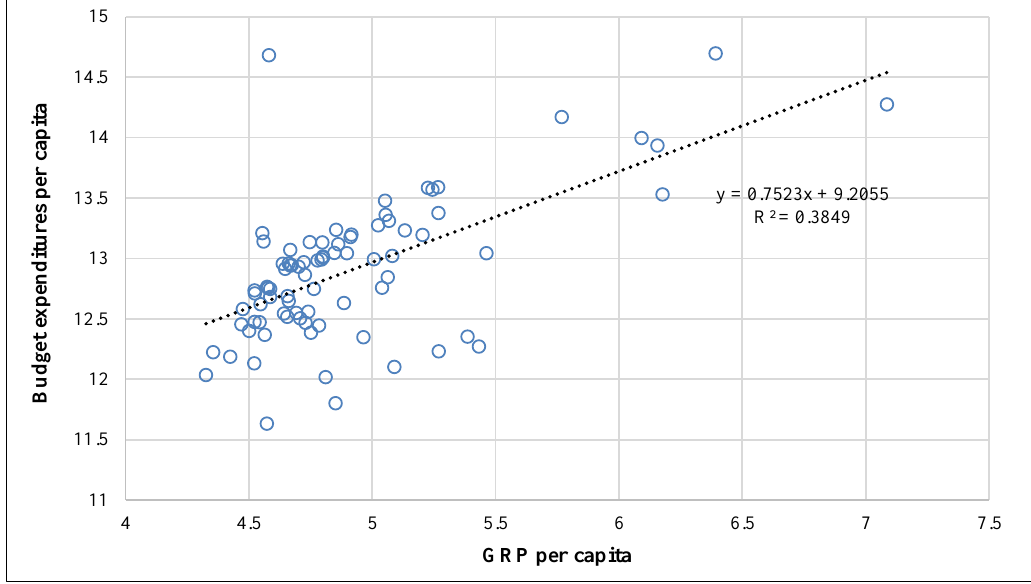
Figure 3. Ratio of the logarithm of the GRP per capita value and the logarithm of the budget expenditures per capita value in